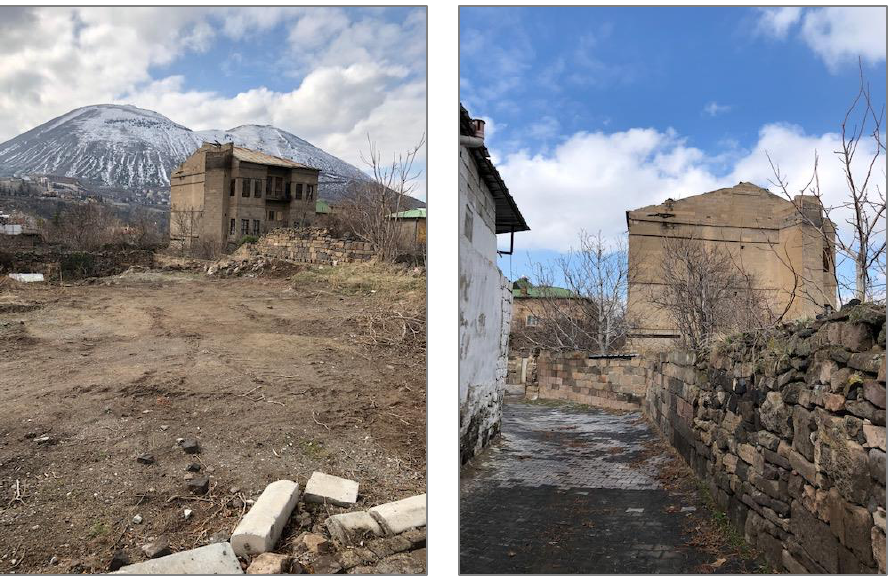
Figure 14, 15 The silhouette of the mansion with Mount Ali and its east facade (Parlak Biçer,